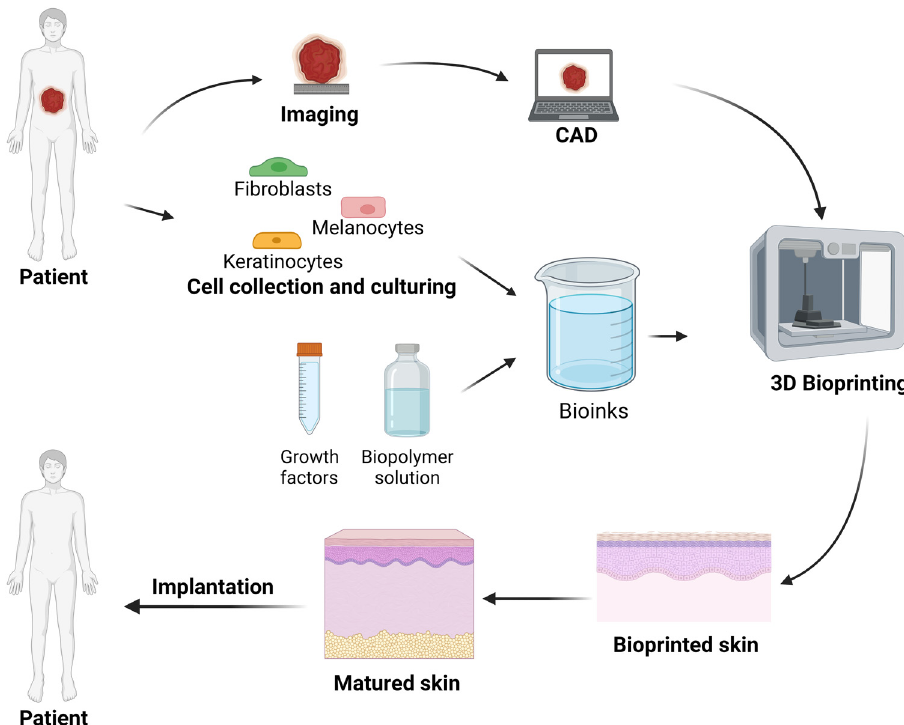
Figure 5: Schematic of the key steps of 3D bioprinting of